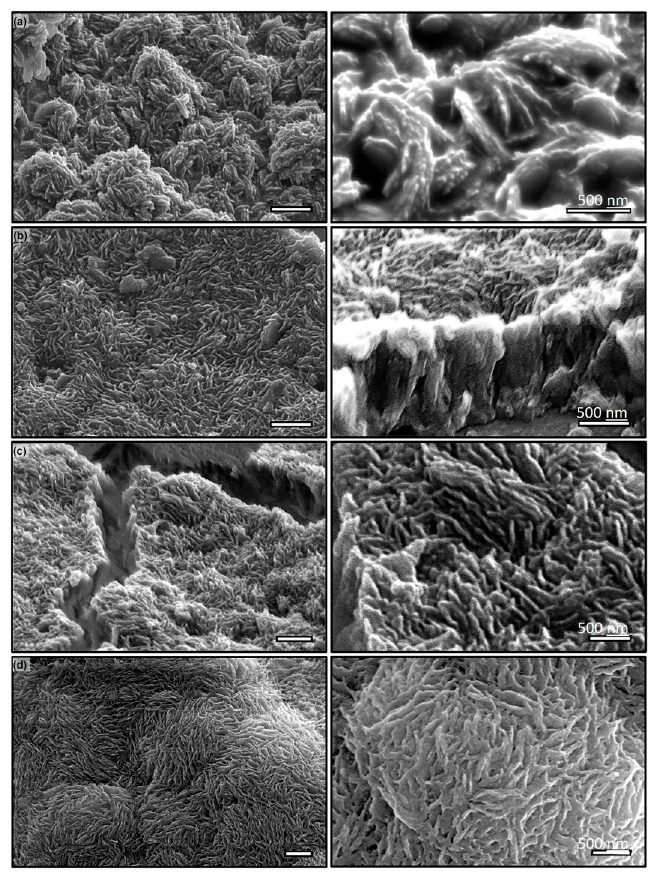
Figure 6. SEM micrographs of the PDMS nanowires over a 75 nm pore size and 2 µm thick AAO template cured for ( a ) 2 ( b ) 3 ( c ) 4 ( d ) 8 weeks, showing confinement effects. ( right ) Corresponding close-ups. Scale: 1 µm or otherwise stated.